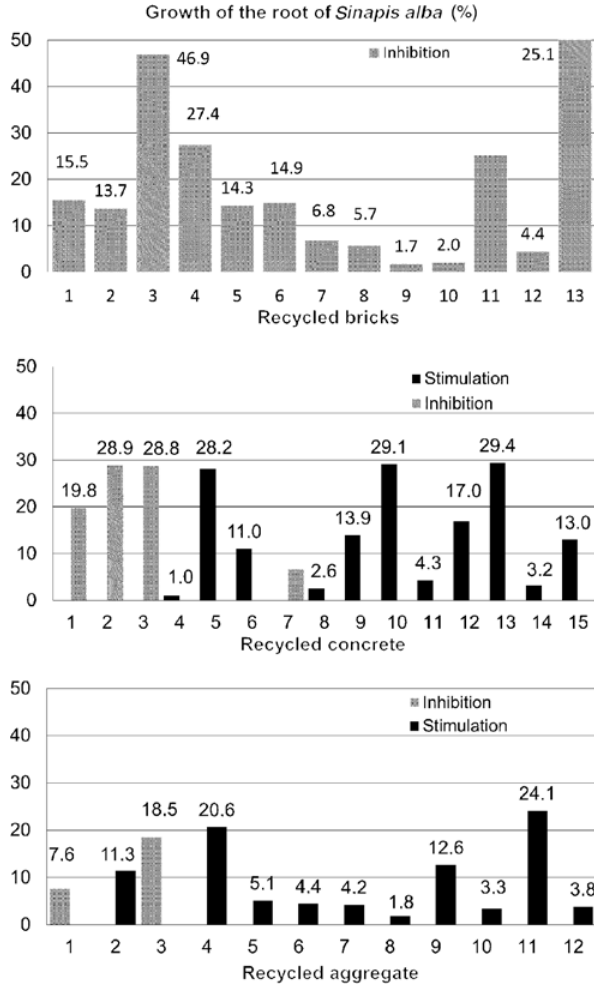
Figure 6: Inhibition or stimulation of the growth of the S. alba root.